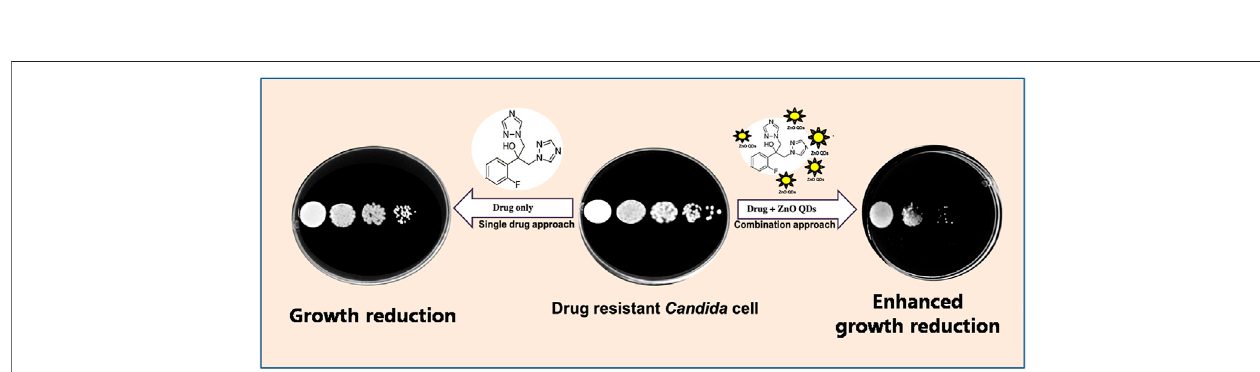
SCHEME 1 | Graphical illustration of this study.